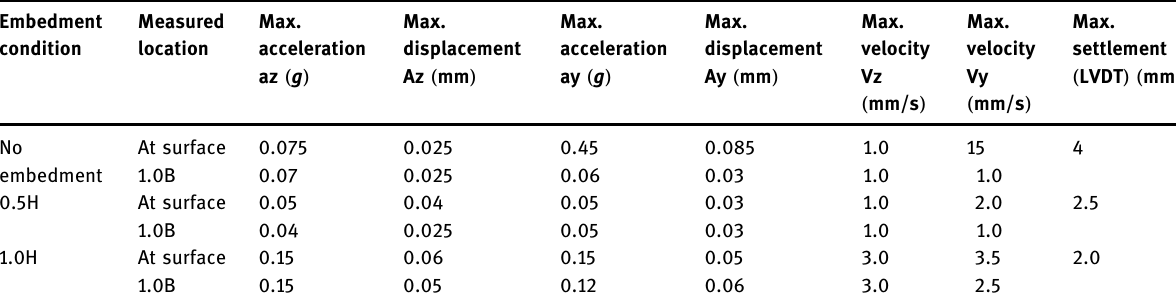
Table 2: Maximum amplitude under the vertical vibration ( 10 Hz